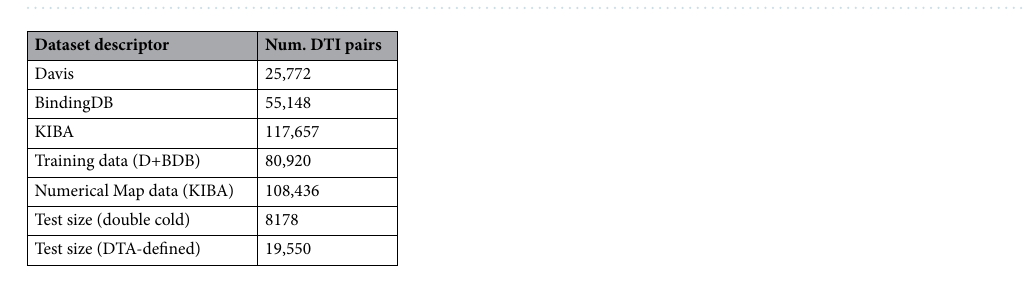
Table 1. DTI dataset sizes and their combined usage in defining the two test